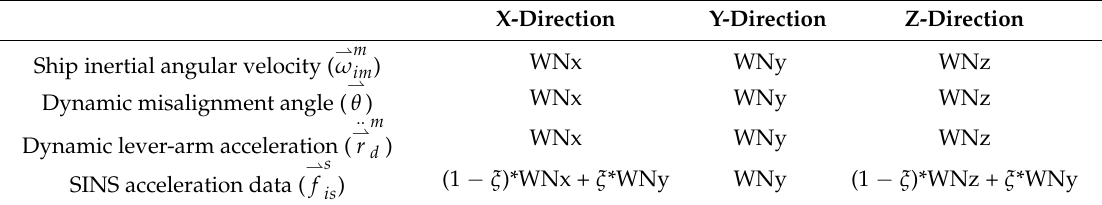
Table 5. Driven noise of different models in each direction. (WNx, WNy, and WNz denote independent Gaussian white noises in three directions, and the weight factor ξ takes a value from 0 to 1). X-Direction Y-Direction Z-Direction